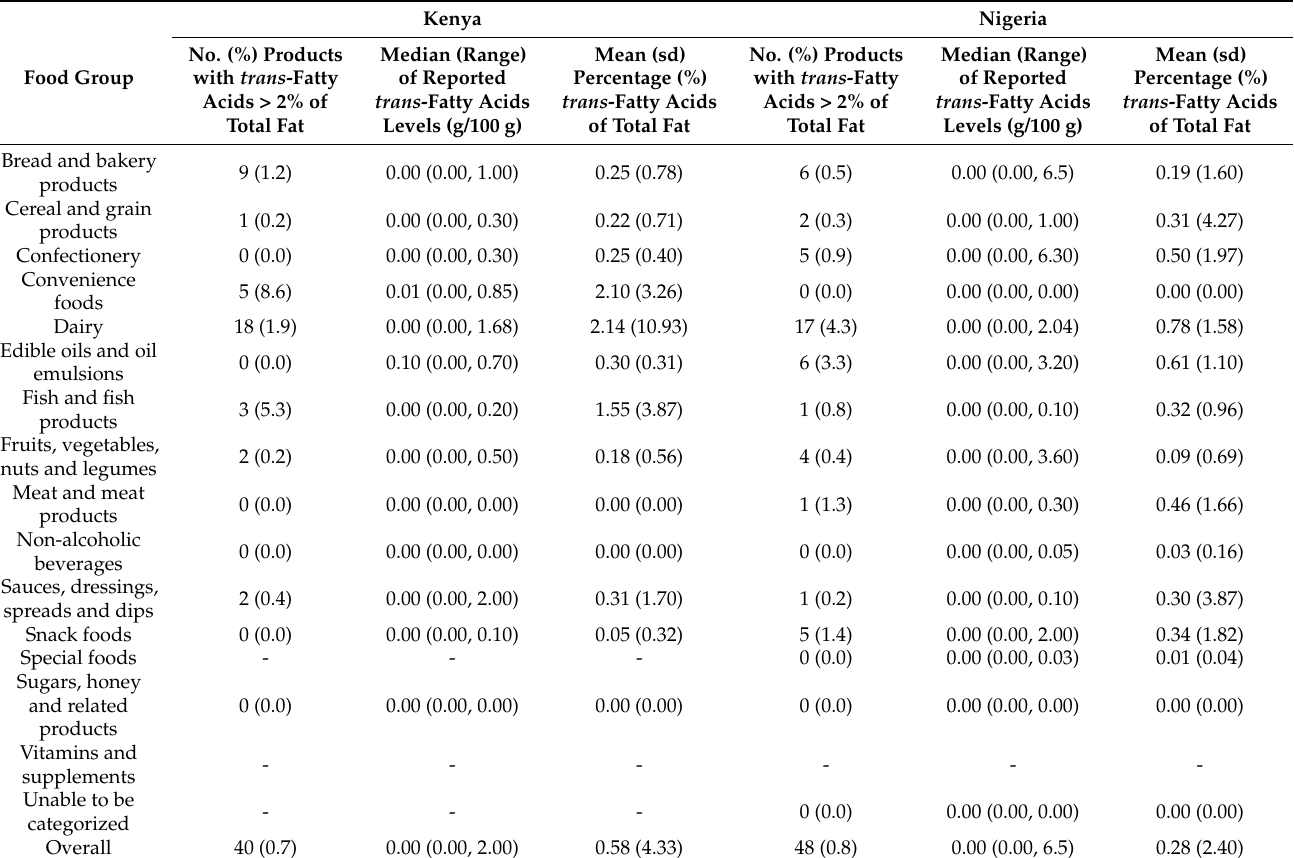
Table 2. Levels of reported trans fat in Kenya and Nigeria for different food groups.